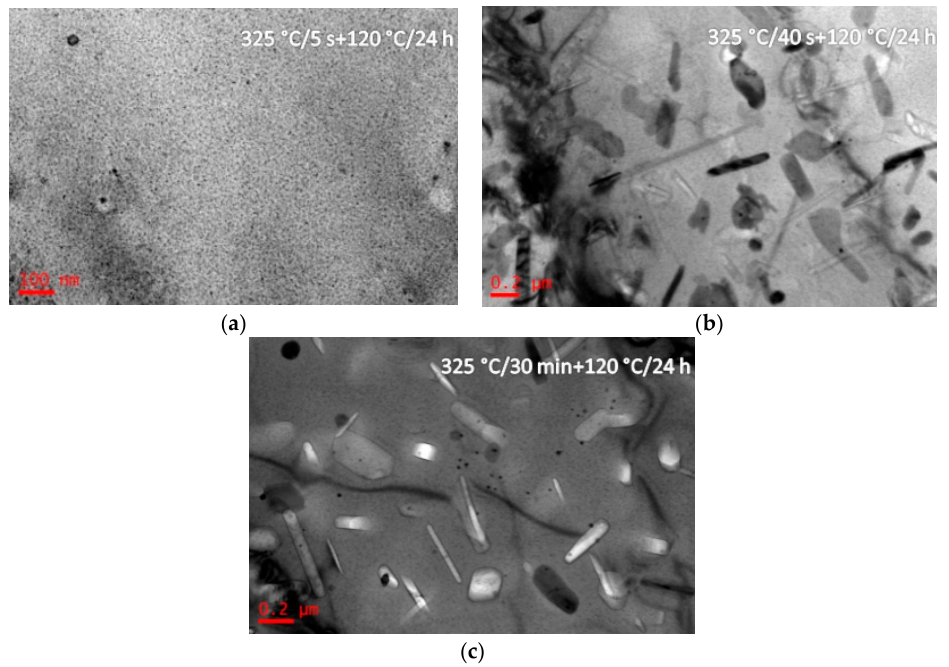
Figure 7. BF images of the studied alloy having been isothermal heat treated at 325 °C for different durations (5 s, 40 s, and 30 min), and then aged at 120 °C for 24 h. The isothermal heat treatment durations are: ( a ) 5 s; ( b ) 40 s; and, ( c ) 30 min.